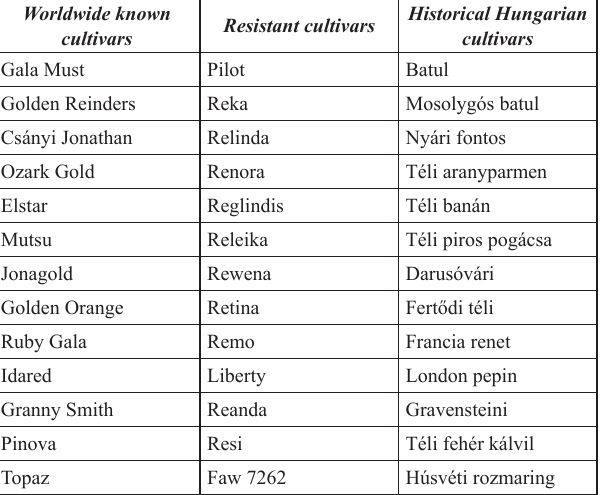
Table 1. Classification of the apple cultivars (Debrecen – Pallag, 2010)